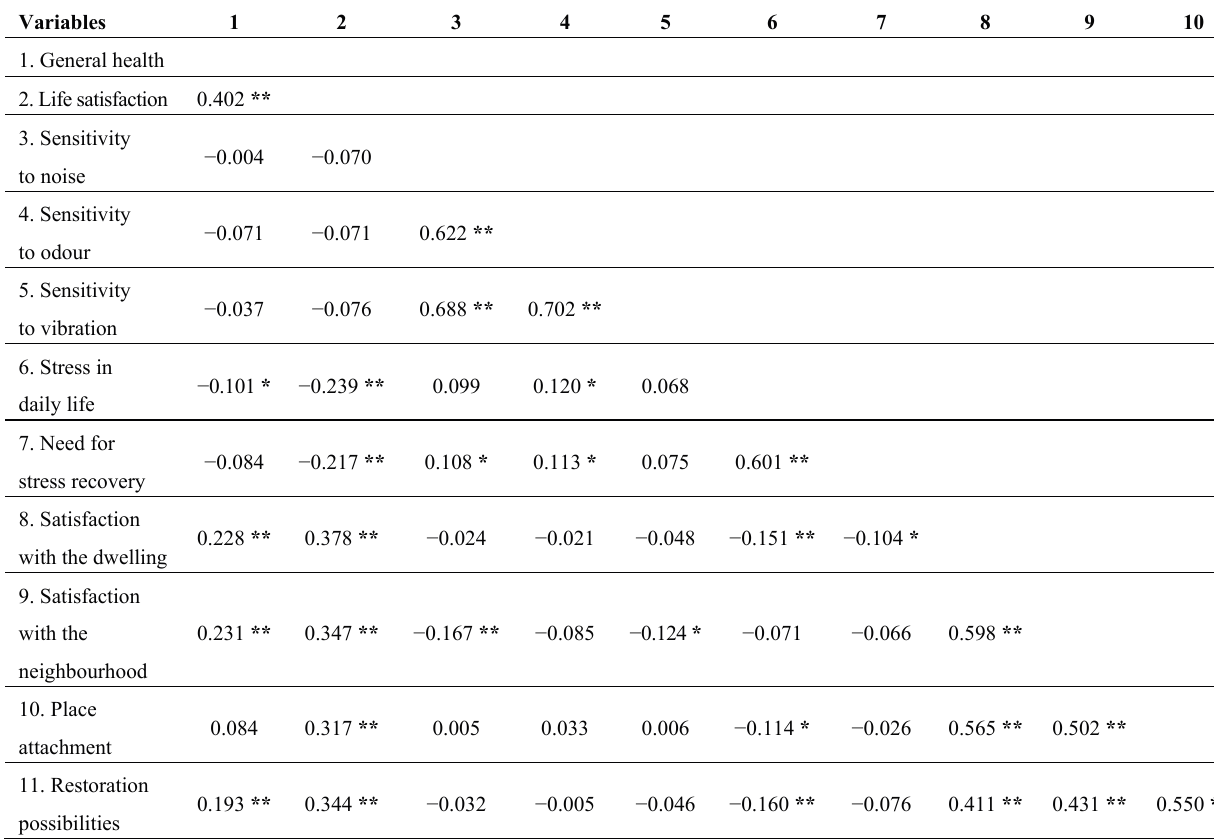
Table 5. Correlations between variables measuring quality of life, sensitivity, stress, residential satisfaction and place